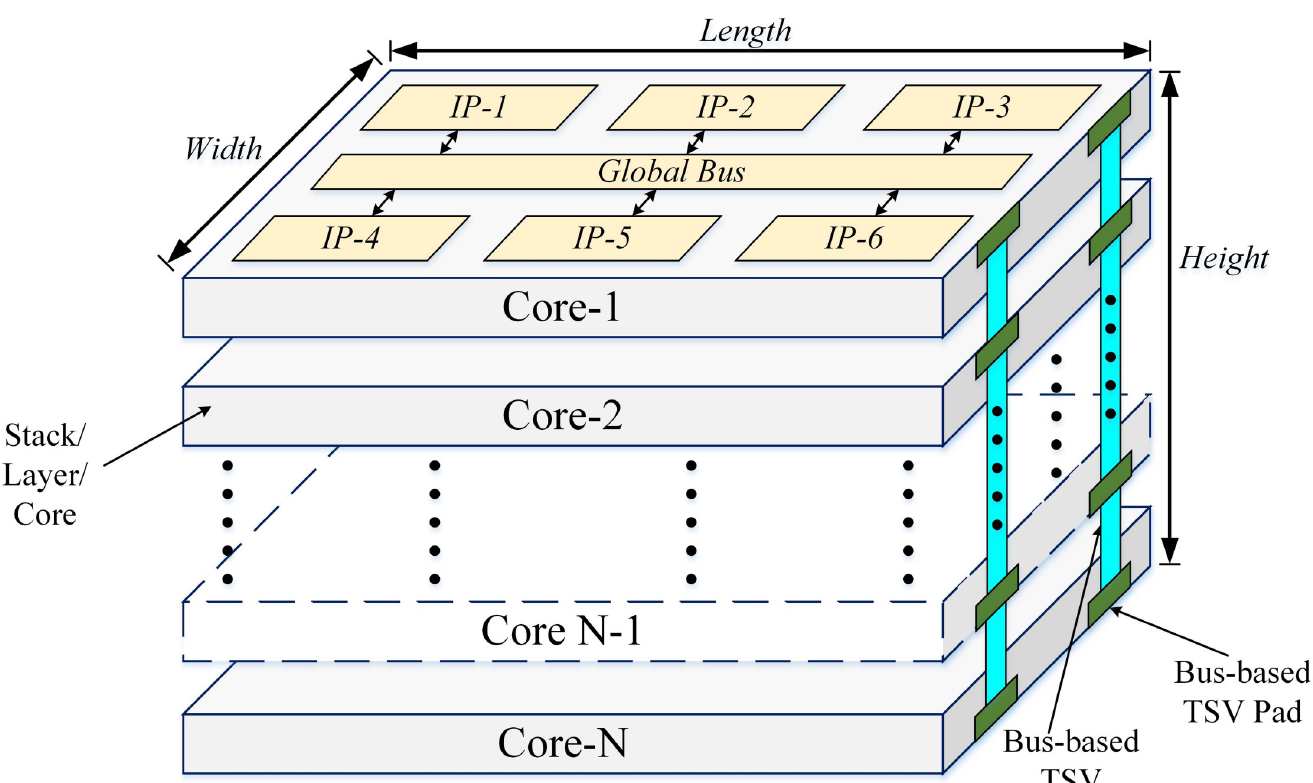
Fig 1. IP-based heterogeneous 3D digital